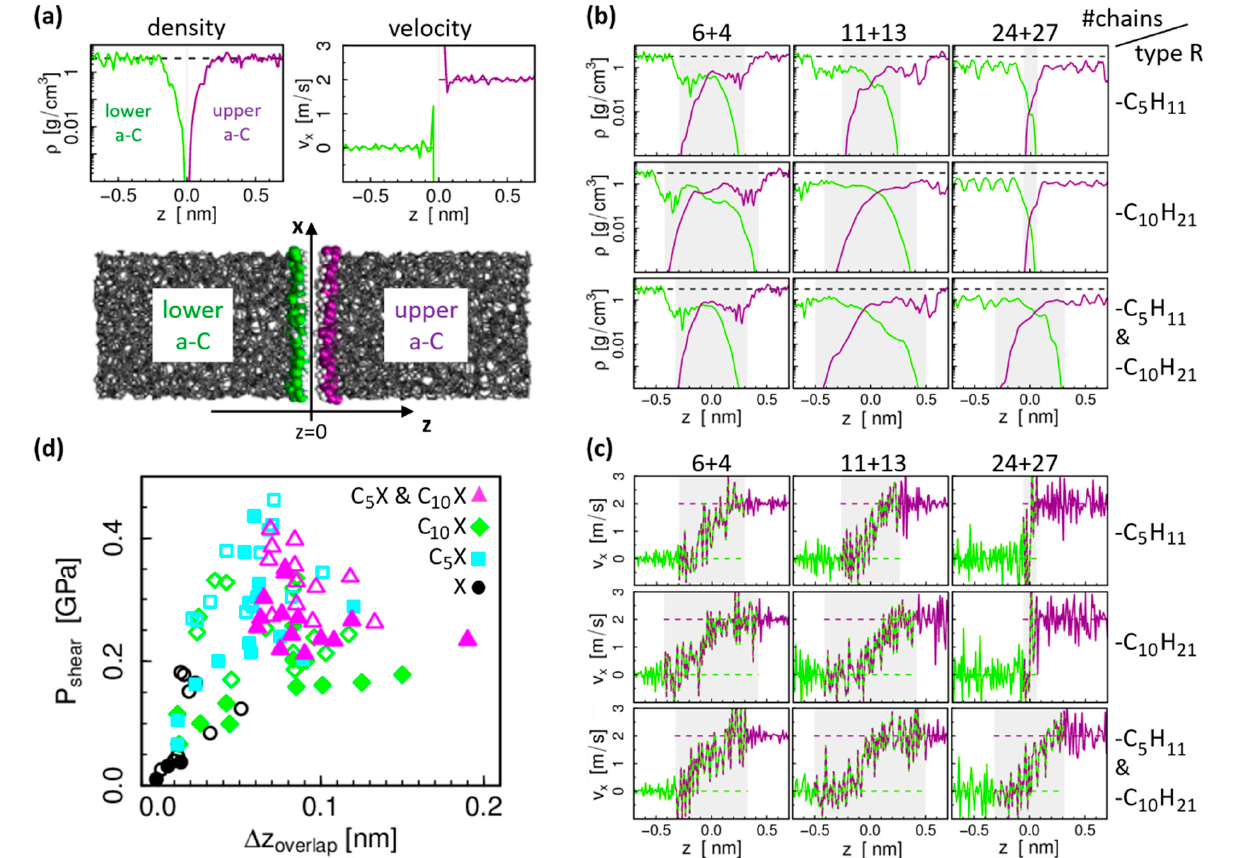
Figure 3. ( a ) Snapshot of the reference system without chains, i.e., purely H-passivated surfaces, and density and velocity profiles in the interface region; green: lower sliding body, violet: upper sliding body. ( b , c ) Density and velocity profiles for systems with chains (only highest a-C density); same color code used in ( a ); the presence of molecular fragments attached to the a-C surfaces leads to a considerable overlap of the lower/upper density profiles (gray shaded area) depending on the number (#) of chains. ( d ) Shear stress as a function of the interpenetration depth of the lower and upper body density profiles for all considered systems. Symbols mark different chain types (symbol shape refers to the chain length; full/open symbols refer to non-polar (X ∈ { H 11 ;H 21 } ) or polar (X ∈ { H 10 OH;H 20 OH } ) chain types,